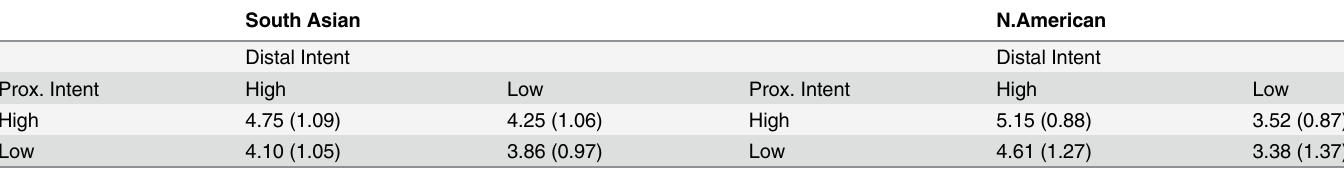
Table 3. Moral sanction of the actor. (Standard deviations in parentheses.) South Asian N.American Distal Intent Distal Intent Prox.